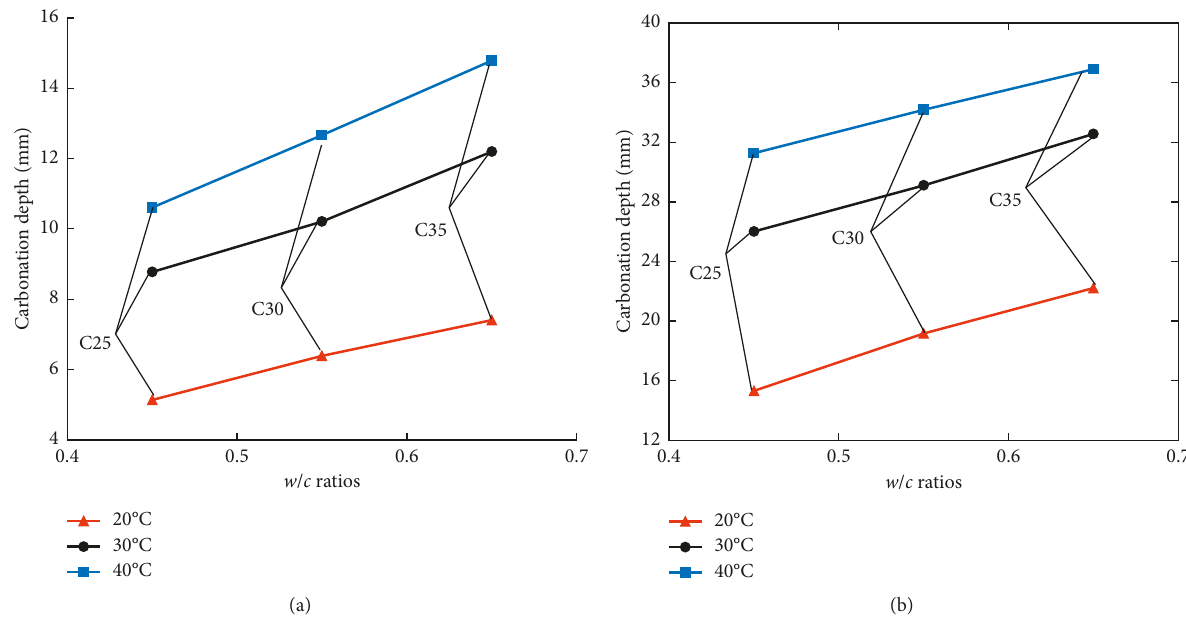
Figure 11: Relationshipbetweenwater-cementratioand carbonationdepth:(a)carbonationtimefor28daysand(b)carbonationtimefor84days.